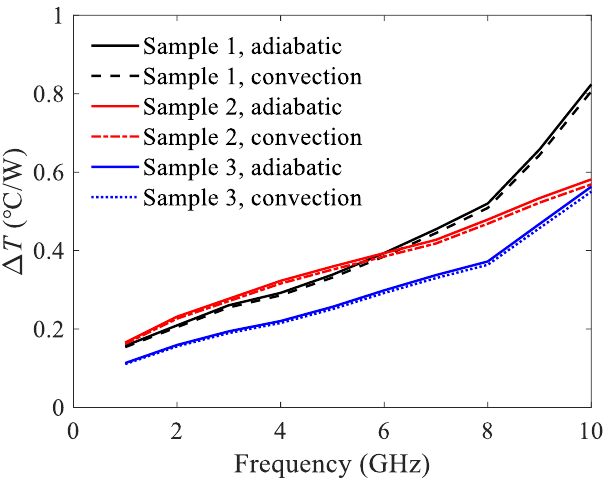
Figure 9. Temperature rises per watt of the U-shaped corrugated SWTLs when the top surface is under adiabatic or natural convection condition.